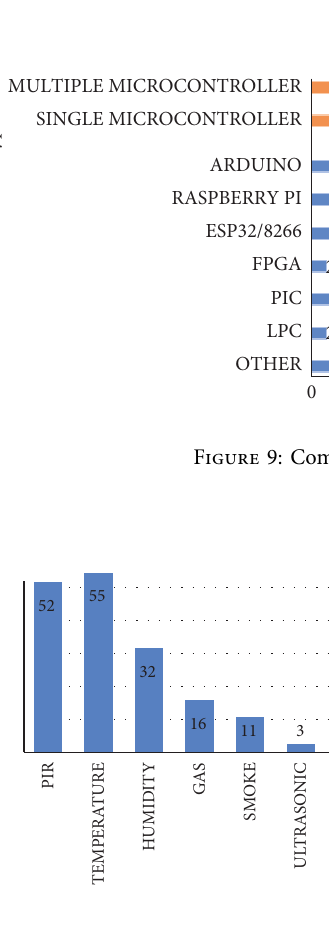
Figure 8: Comparison of technological approaches of SHS.